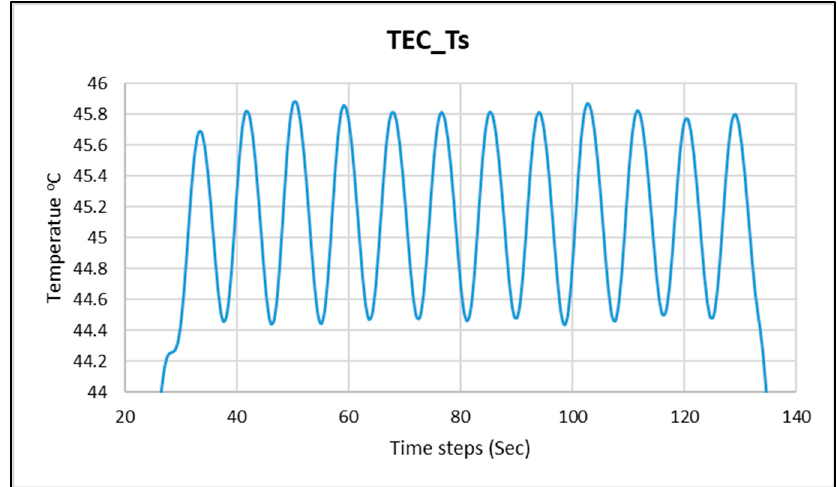
Figure 9. Finding K u and T u for the system.